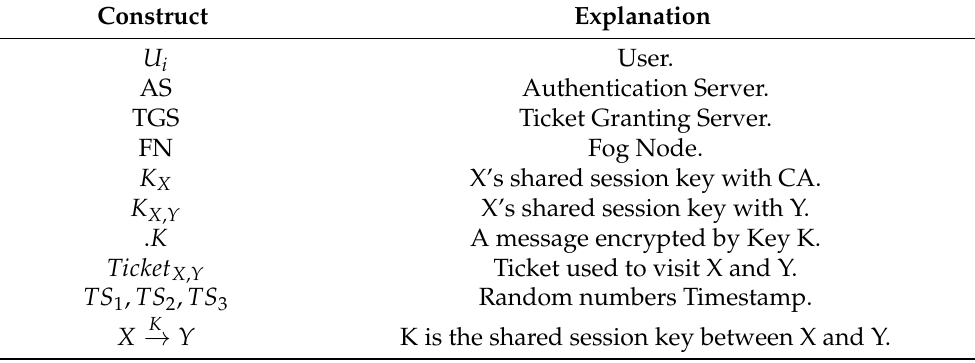
Table 3. Notation and